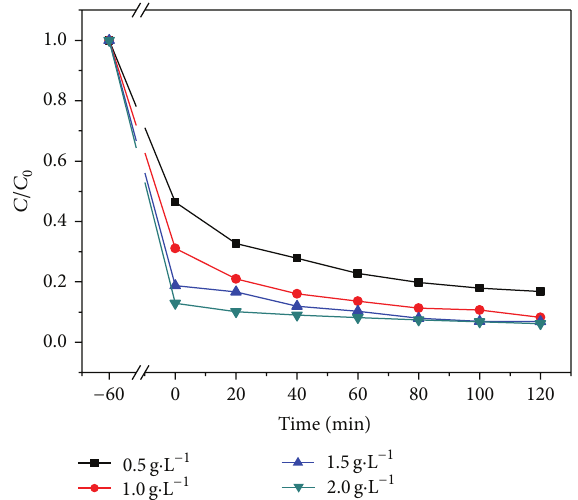
Figure 7: The effect of catalyst concentration on the photocatalytic degradation efficiencies.